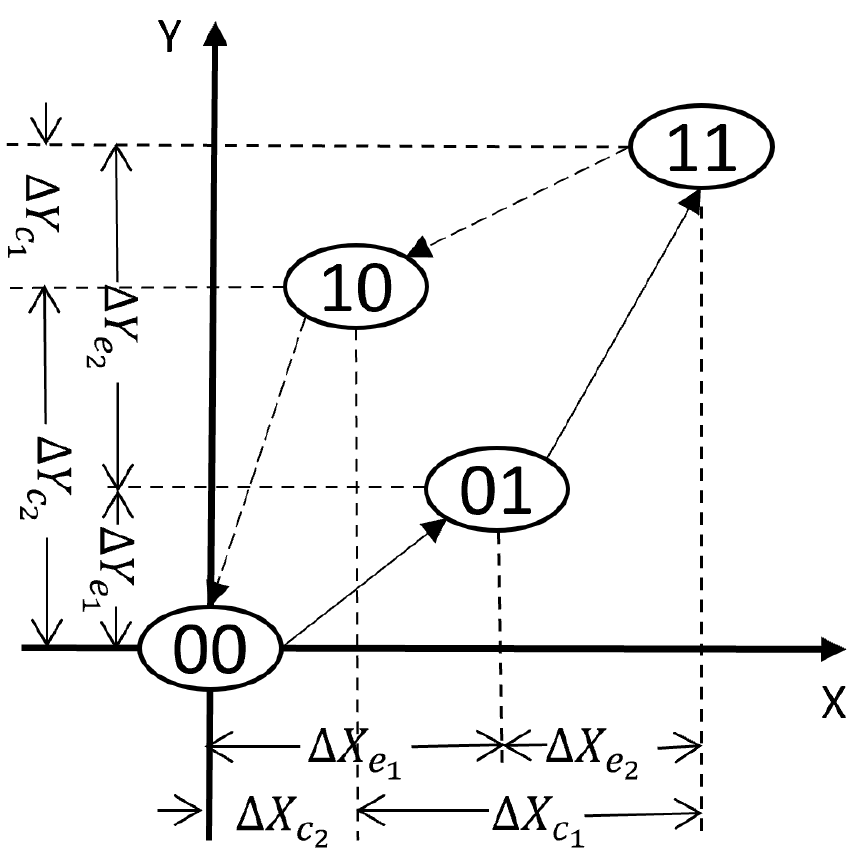
Figure 3. DPI model with two fundamental